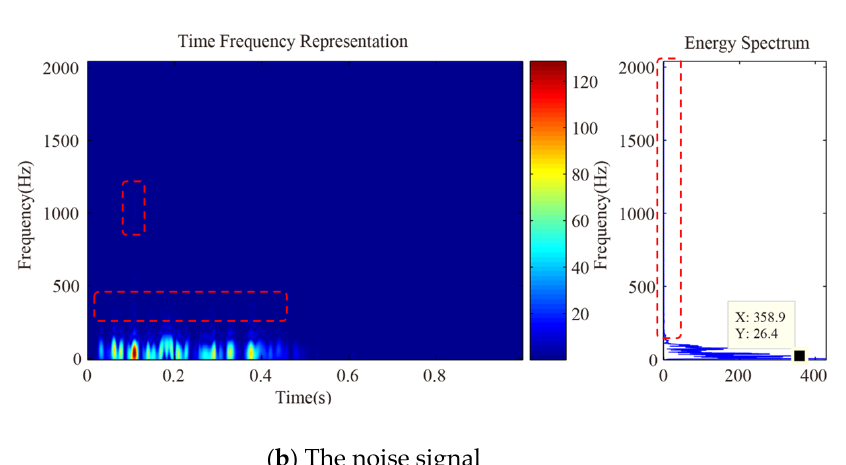
Figure 5. Time-frequency spectrum of